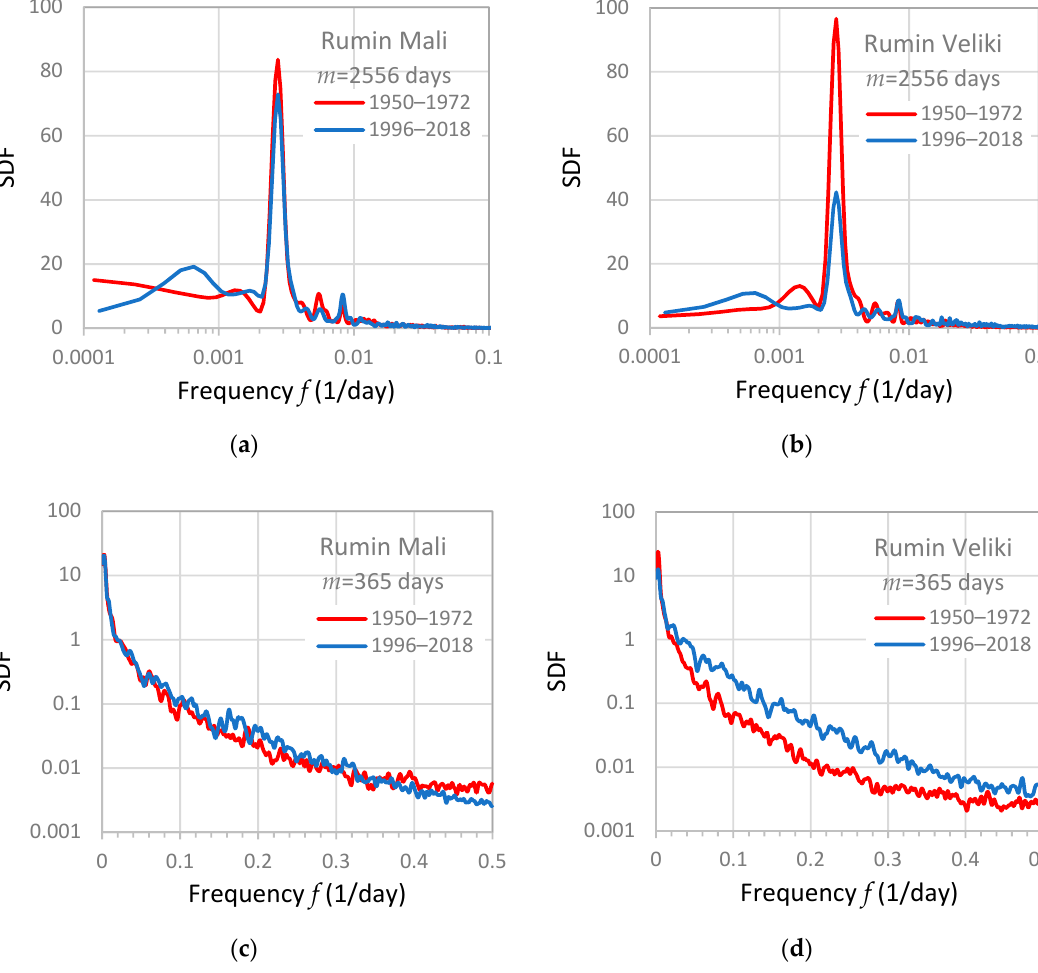
(a) (b) Figure 5. Spectral density function (SDF) of rainfall for: ( a ) MS Sinj (P S ) and MS Livno (P L ) for period 1996 – 2018 for truncation point m = 2556 days, and ( b ) RG Biteli ć Donji (P B ) for period 1999 – 2008 for truncation point m = 1220 days.